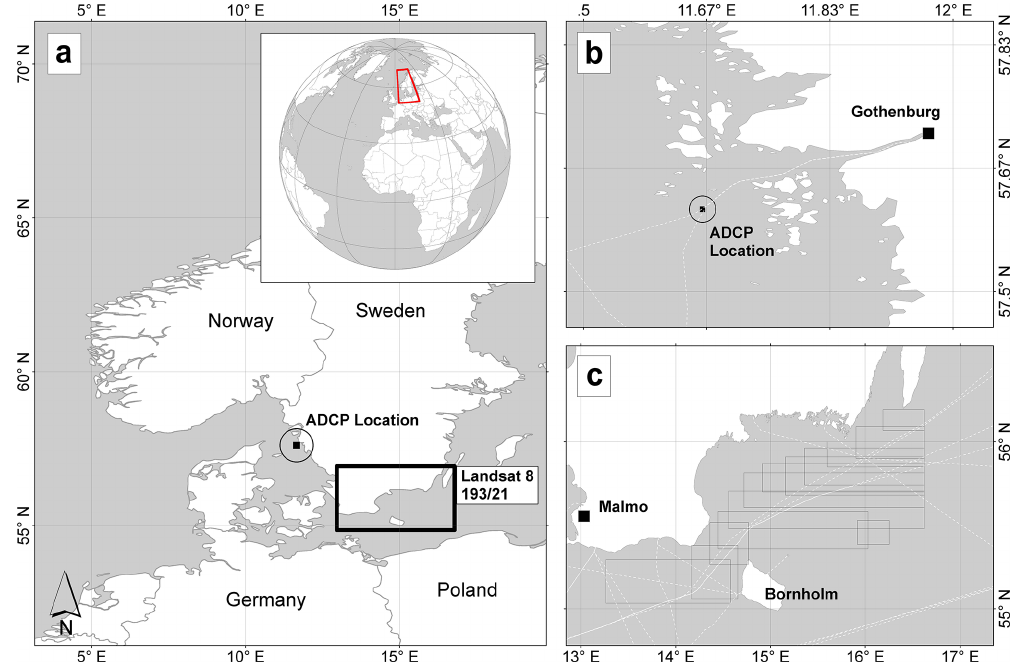
Figure 1. Overview of the two study areas (a) showing the location of the ADCP under the shipping lane outside Gothenburg (b) and the area covered by the analysed satellite images (c) . White dashed lines indicate ship routes of ferry lines, and the boxes in (c) indicate the area defined as the shipping lane area in the satellite image analysis. The shipping lane and traffic-separated zone north of Bornholm are shown in Fig.